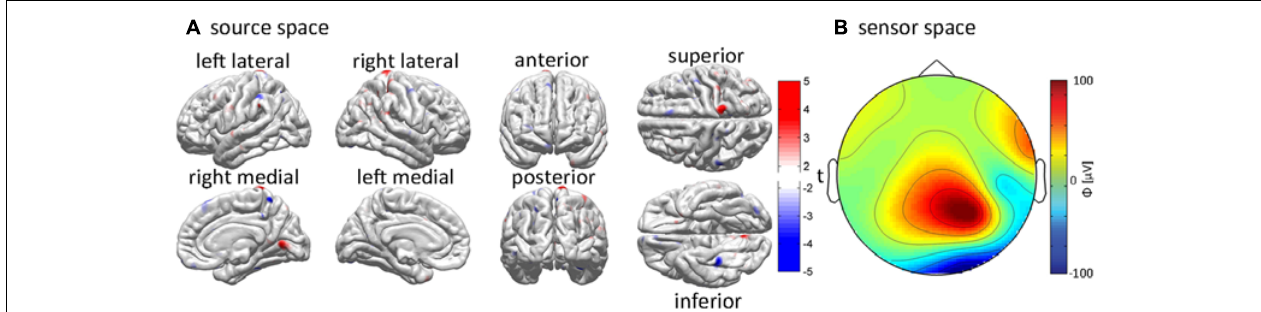
is plotted using t scores, which indicate the likelihood for each cortical location to be electrically active.The magnitude of t indicates whether the localized electric current is oriented out of ( t > 0, red hues) or into ( t < 0, blue hues) the cortex. (B) The interpolated values of the potentials measured at each sensor location are mapped over an idealized, circular representation of the scalp to generate a topographic map. Color indicates the magnitude of the recorded electric potential (cid:3) in μ V. See Irimia etal. (2013b) for further